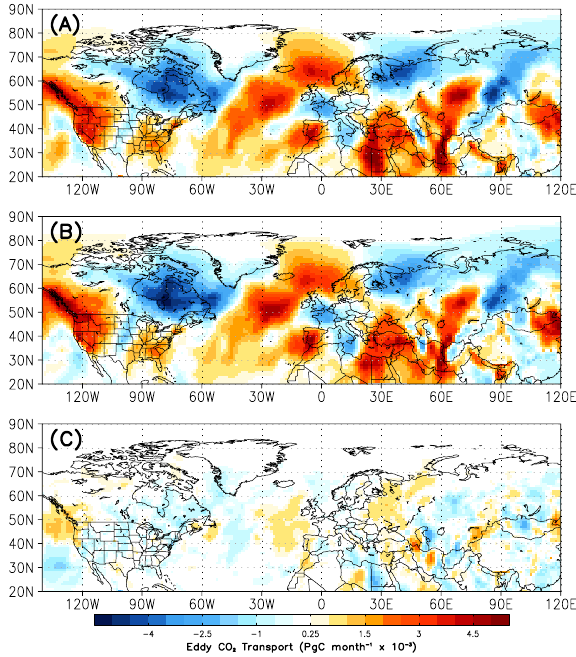
Fig. 4. Spatial structure of column integrated meridional eddy CO 2 transport averaged over the period June-July-August for (A) G4R20 and (B) G5F05. (C) Difference in eddy transport, or (B) minus (A)